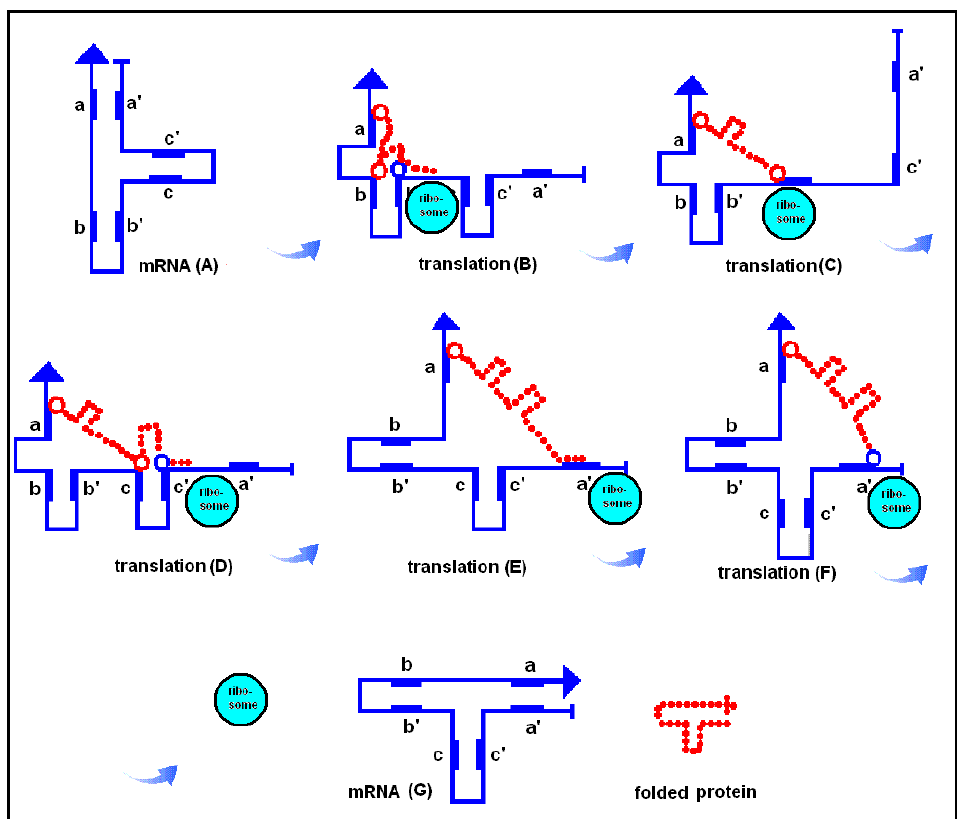
Figure 6. RNA-assisted (translational) protein folding. There are three reverse and complementary regions in a mRNA (blue line, A): a-a', b-b', c-c', which fold the mRNA into a T-like shape. During the translation process the mRNA unfolds on the surface of the ribosome, but subsequently refolds, accompanied by its translated and lengthening peptide (red dotted line, B-F). The result of translation is a temporary ribonucleotide complex, which dissociates into two T-shape-like structures: the original mRNA and the properly folded protein product (G). The red circles indicate the specific, temporary attachment points between the RNA and protein (for example a basic amino acid) while the blue circles indicate amino acids with exceptionally high affinity for the attachment points (for example acidic amino acids); these capture the amino acids at the attachment point and dissociate the ribonucleoprotein complex. Transfer-RNAs are of course important participants in translation, but they are not included in this scenario. (Figure is reproduced from